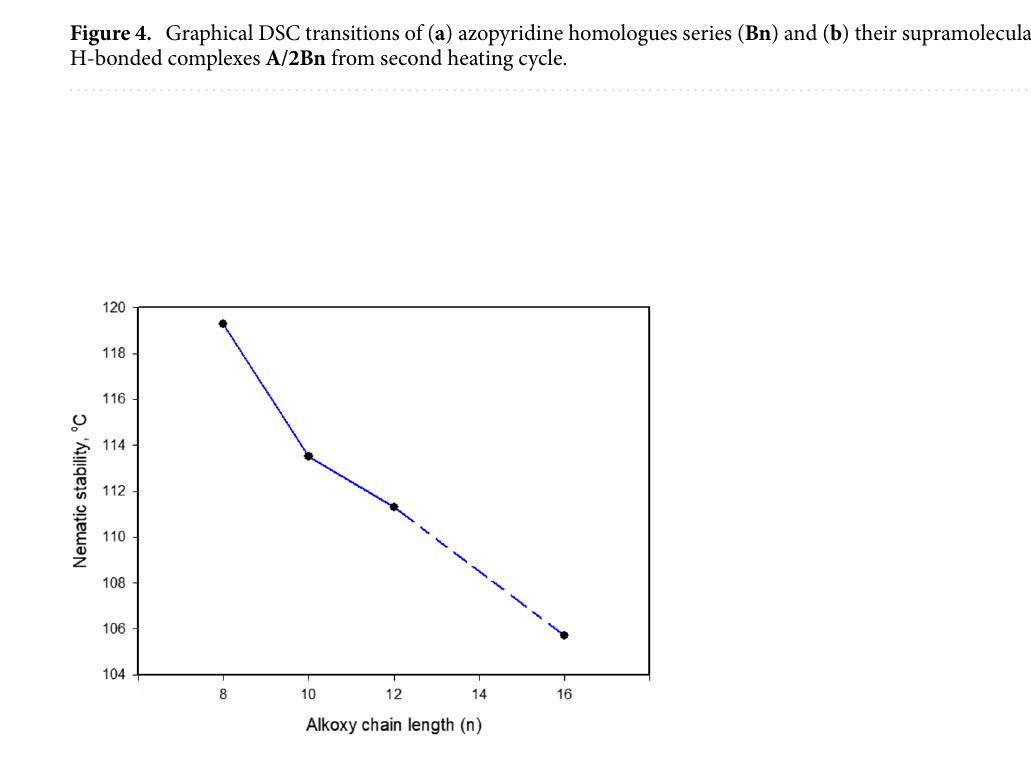
Figure 5. Dependence of nematic stability ( T N−I ) on the terminal alkoxy chain-length